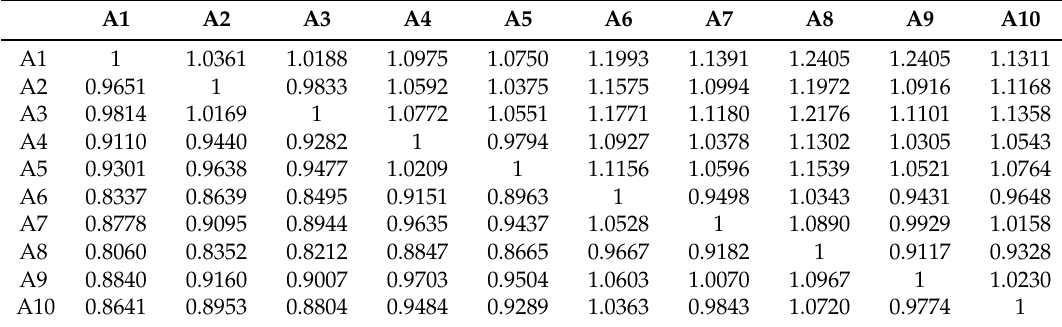
Table 6. WPM pairwise comparison